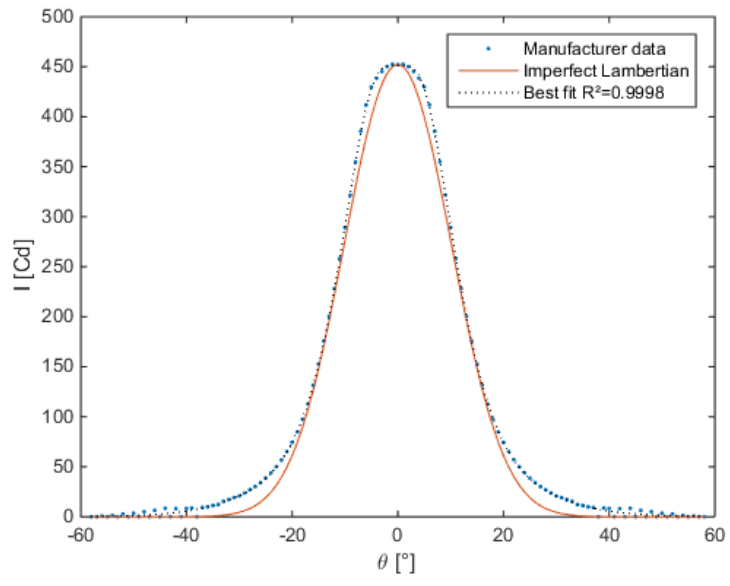
Figure 5. Luminous intensity distribution for narrow angle lens combined with the selected LED (data obtained at forward current of 350 mA, luminous flux of 100 lm).